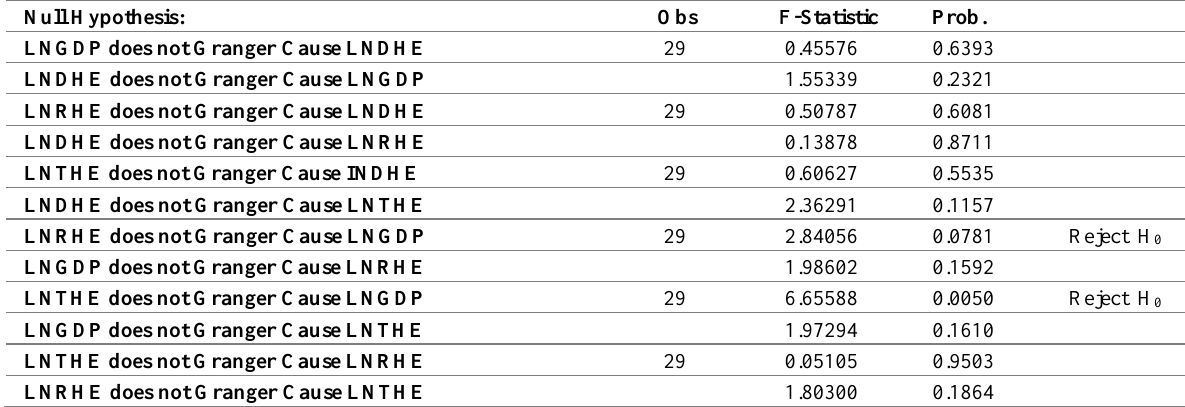
Table 8: Pairwise Granger Causality Tests